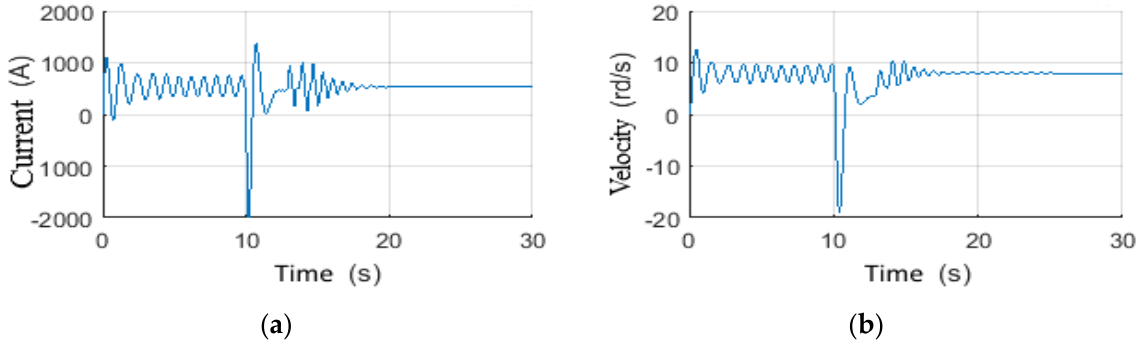
Figure 33. Observer-based controller responses for Top drive, Scenario-9: ( a ) Current, ( b ) Velocity.